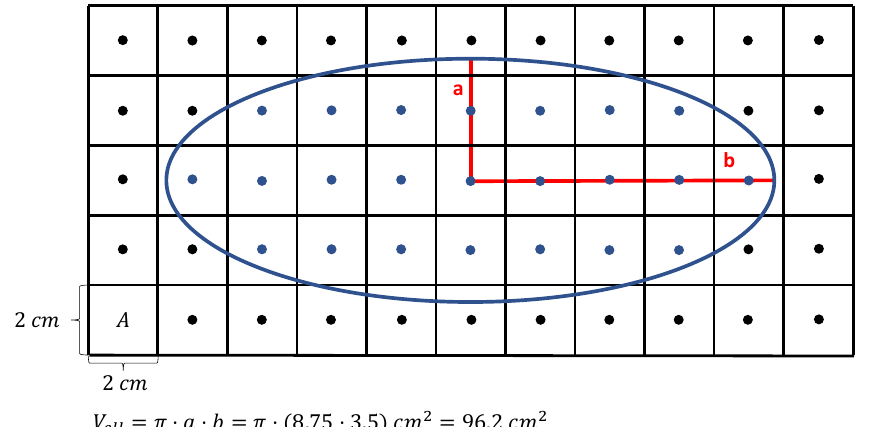
Figure 11. Schematic drawing of a 2D ellipse in a discrete and continuous volume. It is shown that the continuous volume for ellipses and therefore also for ellipsoids is in general bigger than the discrete volume.